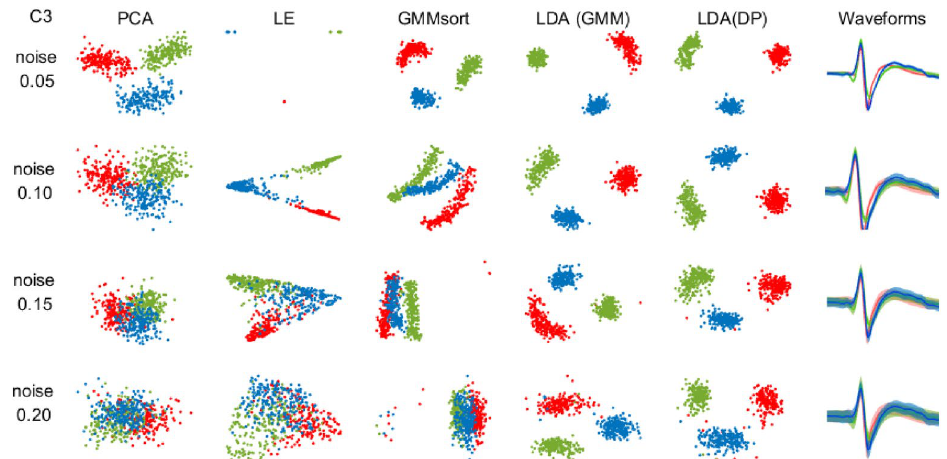
Figure 3. Two-dimensional feature subspace for algorithms on dataset C3 under four noise levels. For comparing the feature extraction capability of each algorithm, the data points were colored according to the ground truth. Red, green and blue dots represent the features extracted from three clusters, respectively. The last column shows the average spike waveforms of three clusters obtained by LDA-DP, and the shaded part represents the standard deviation.